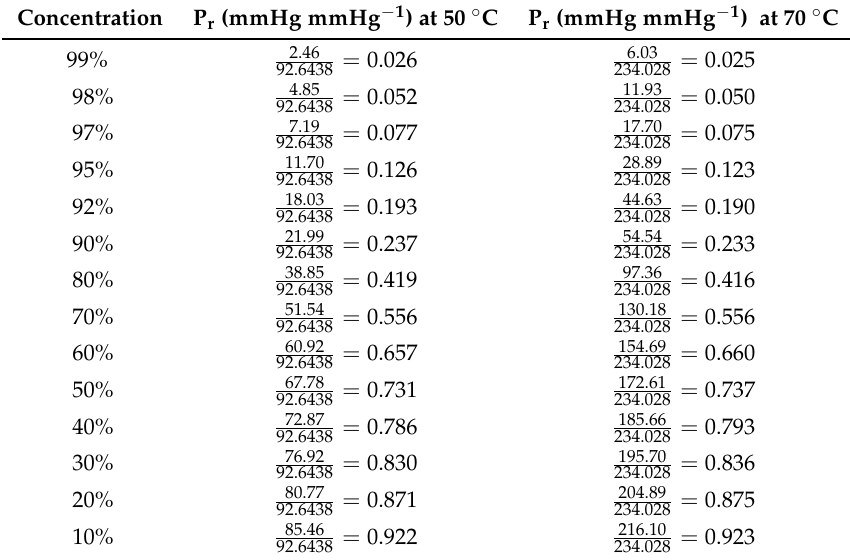
Table A6. Pressure relative to different concentrations ( H 2 O / H 2 SO 4 mix) and at two temperatures (50 ◦ C and 70 ◦